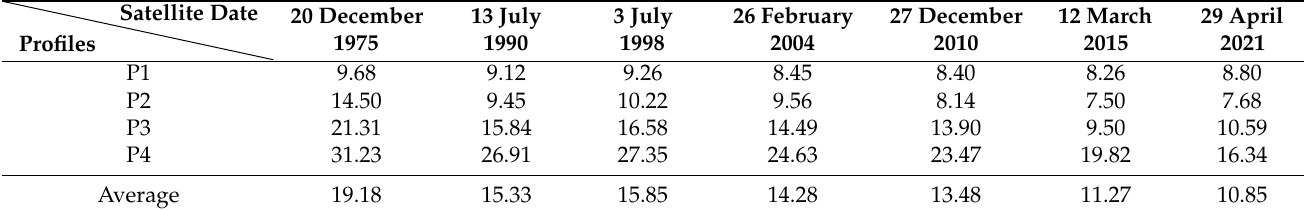
Table 2. Changes in the width of the South Passage